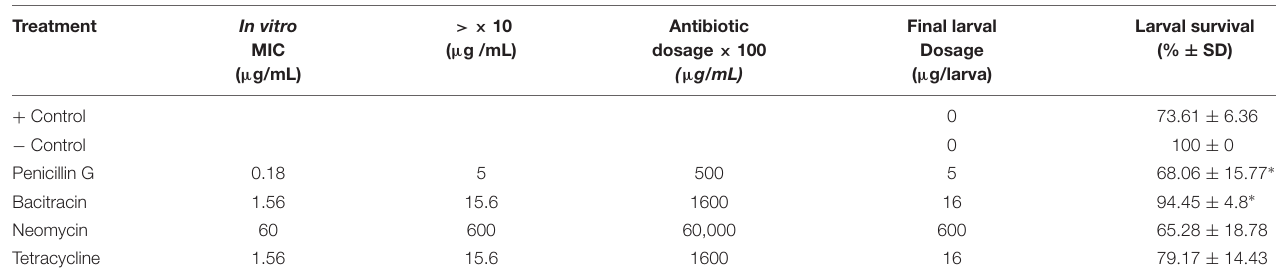
Survival percentages ± Standard deviation after 72 h of being treated with 10 µ L injected doses of 10 × in vitro MIC against 10 µ L injection of 10 7 JBCNJ055. “ + ” indicates no treatment administered. “ − ” indicates infection with 0.1% peptone water as trauma controls. ∗ Significantly different when compared to + control (P > 0.05) (Man–Whitney